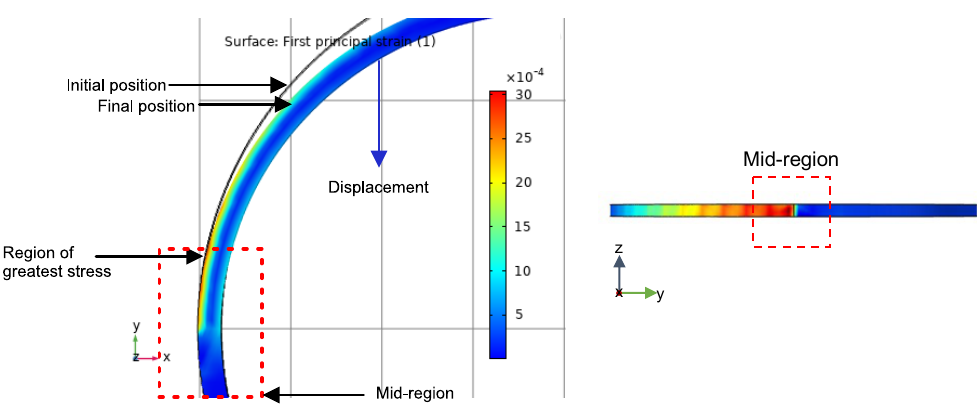
Figure 2. Structural simulation model.